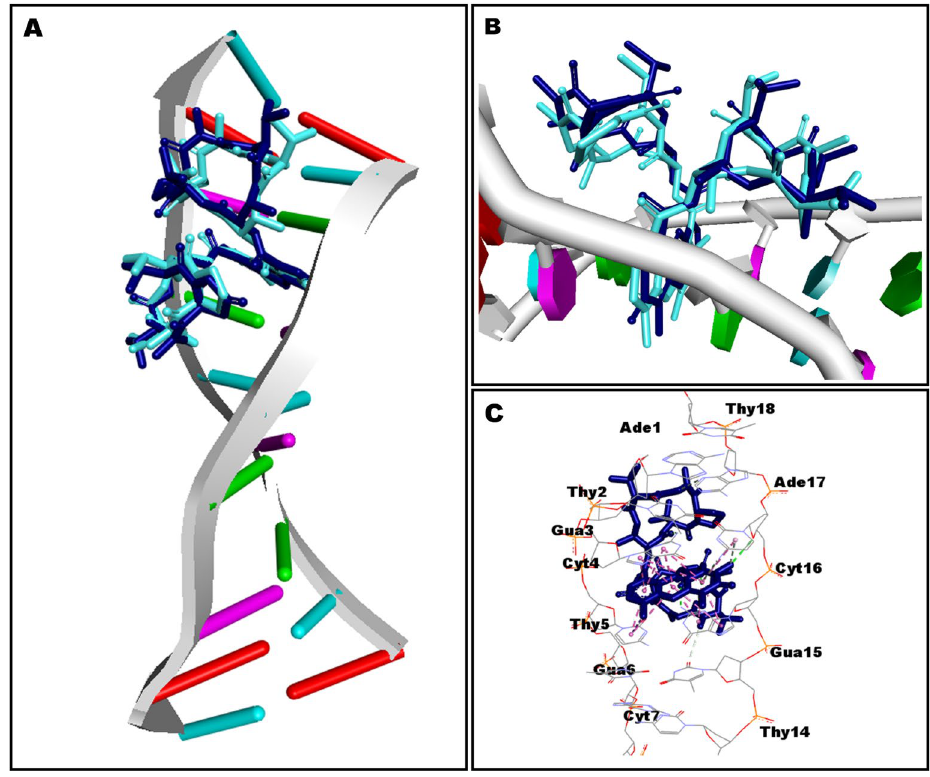
Figure 10. Docked compound K 1 in the DNA. Co-crystallized actinomycin D is shown in cyan color while docked compound K 1 is portrayed as a stick in dark blue color. ( A ) Whole DNA fragment used in docking has been shown; ( B ) phenoxazine ring occupying between the base pairs; ( C ) detailed intermolecular contacts are displayed. Biovia Discovery Studio Visualizer 2020 program was used for generating the images (https:// disco ver. 3ds.